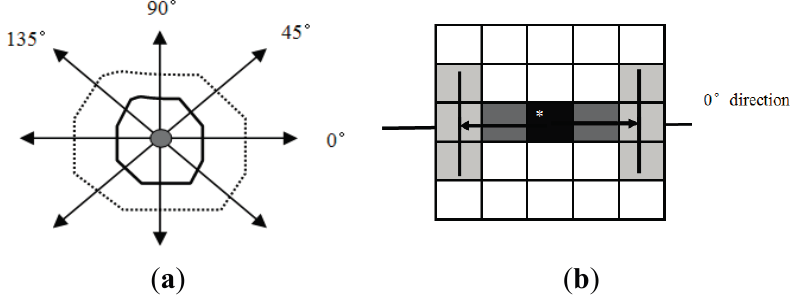
Figure 4. Diagram for detection algorithm. ( a ) The four directions; ( b ) detection template in 0° direction of a froth image of large